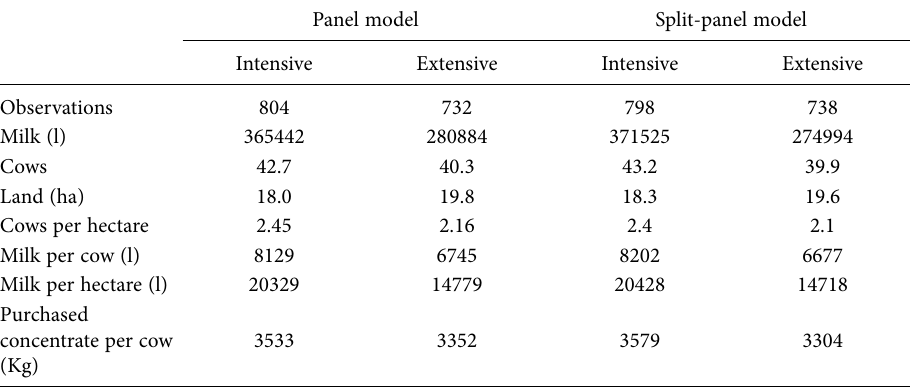
Table 3. Characteristics of the estimated production classes (sample means).